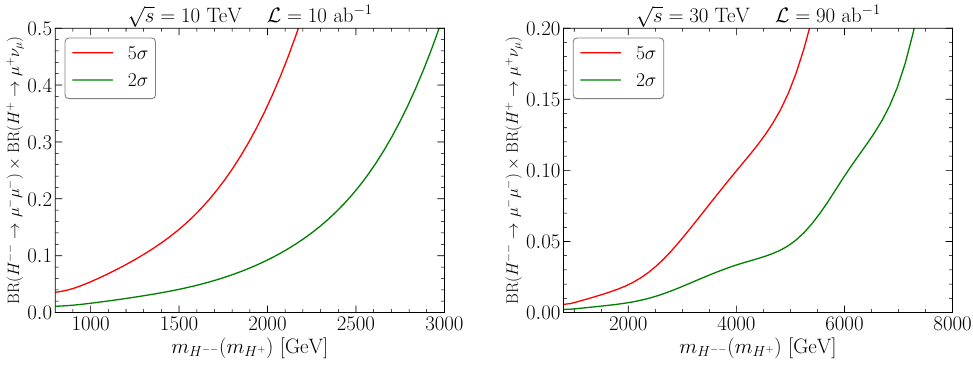
Figure 17 . The product of reachable branching ratios of H ±± → µ ± µ ± and H ∓ → µ ∓ ν corre- sponding to 2 σ (green) and 5 σ (red) significance versus m √ muon collider with s = 10 TeV, L = 10 ab − 1 (left) and